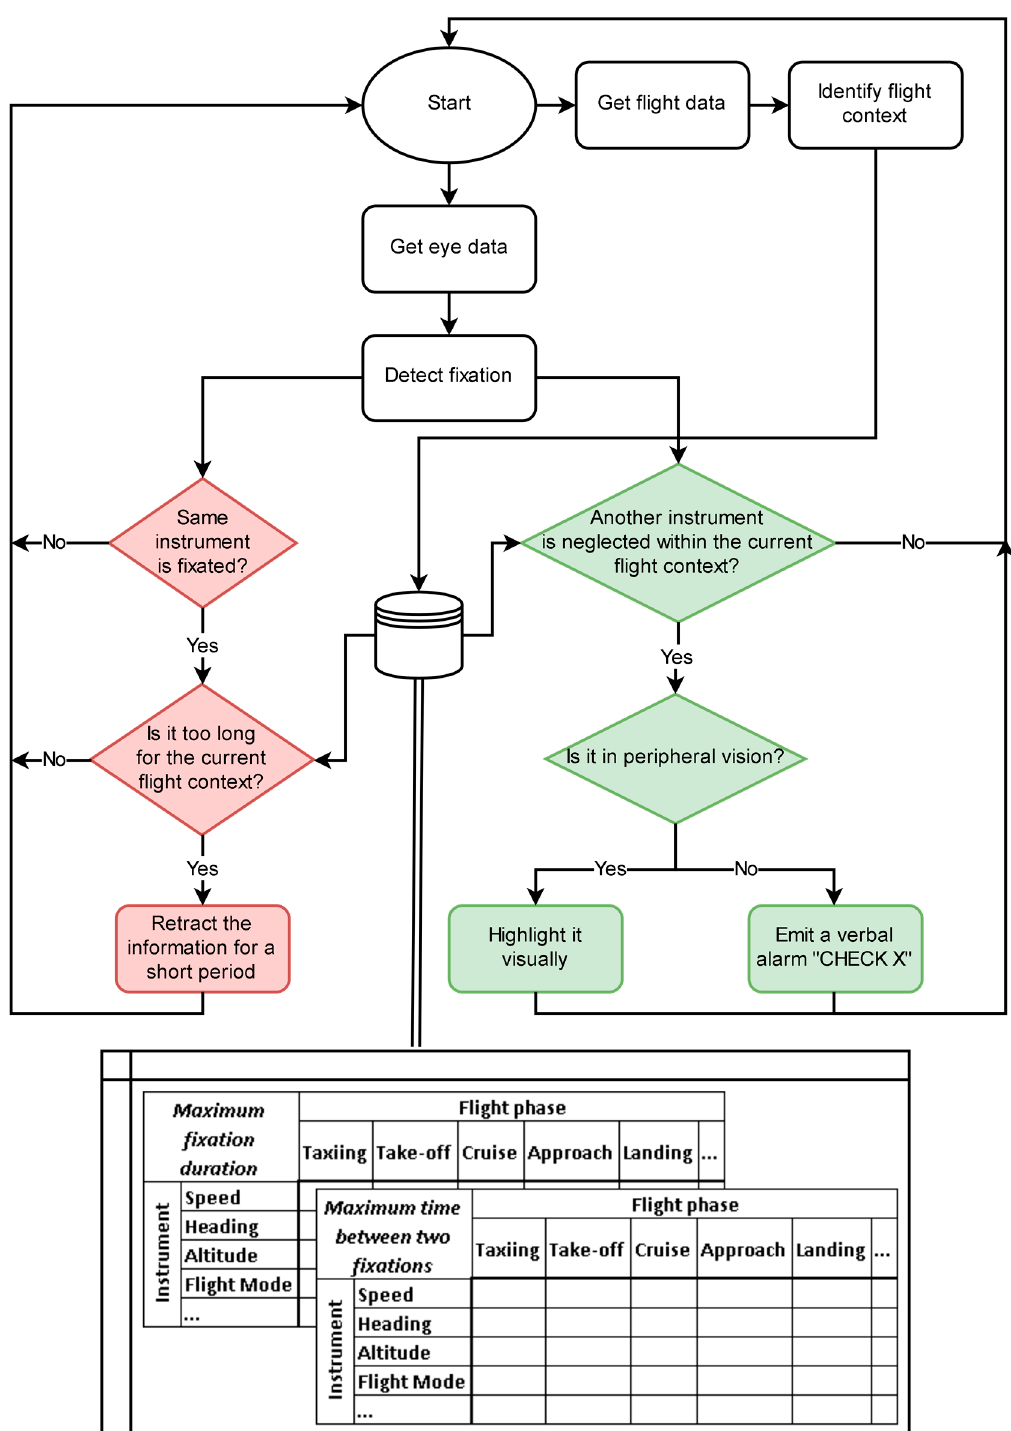
Figure 3. An example of a possible flowchart of stage III “Gaze-Based Flight Deck Adaptation”. The red pathway concerns an excessive focus on a particular instrument. The green pathway concerns a lack of instruments’ monitoring. In this example, the visual behavior database consists of a set of rules concerning maximum allowed values (a fixation duration, a time between two fixations) as a function of both instrument and flight context.